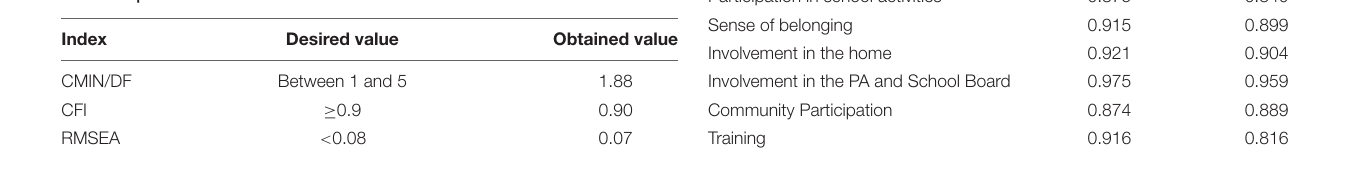
TABLE 6 | Goodness of fit indices of the IMFIS-TP.